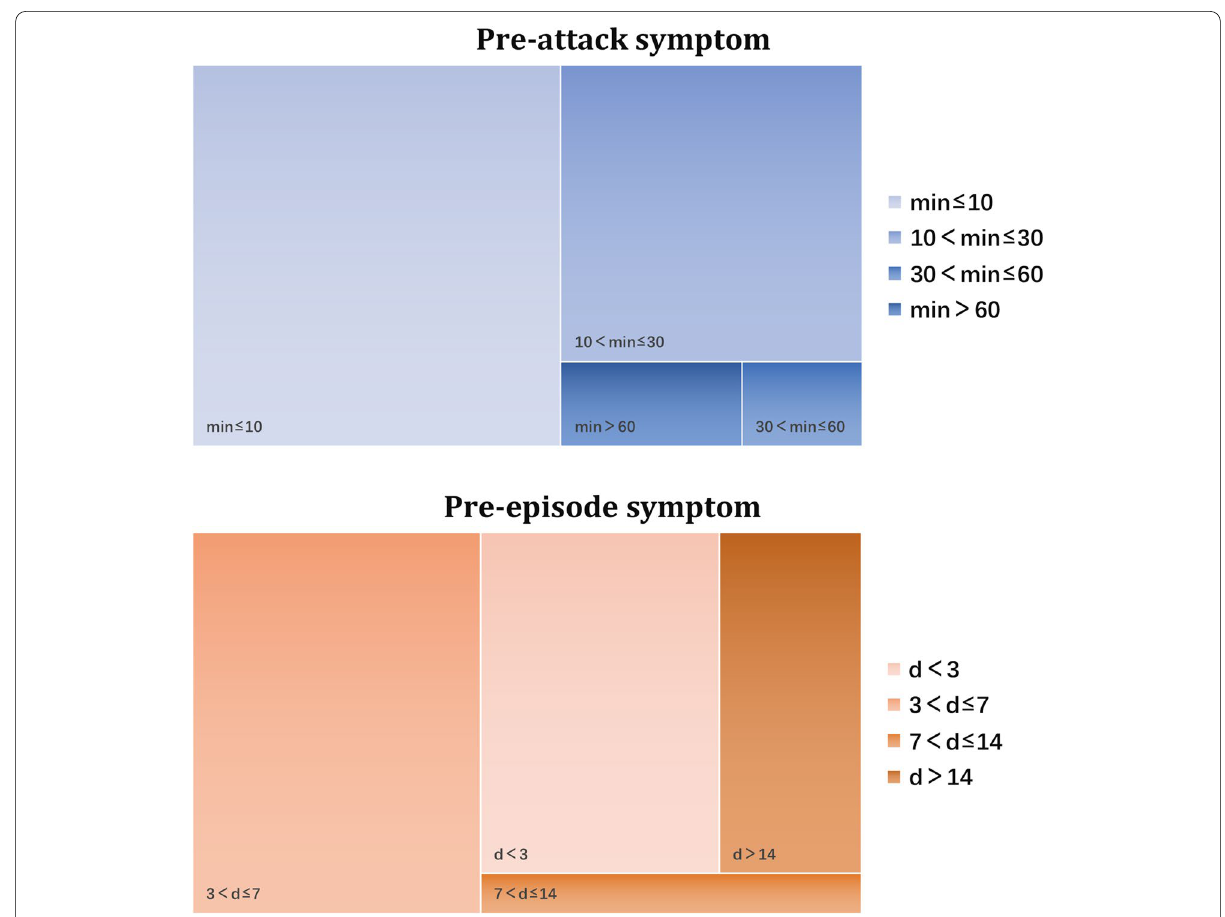
Fig. 3 Durations of pre-attack and pre-episode symptoms before